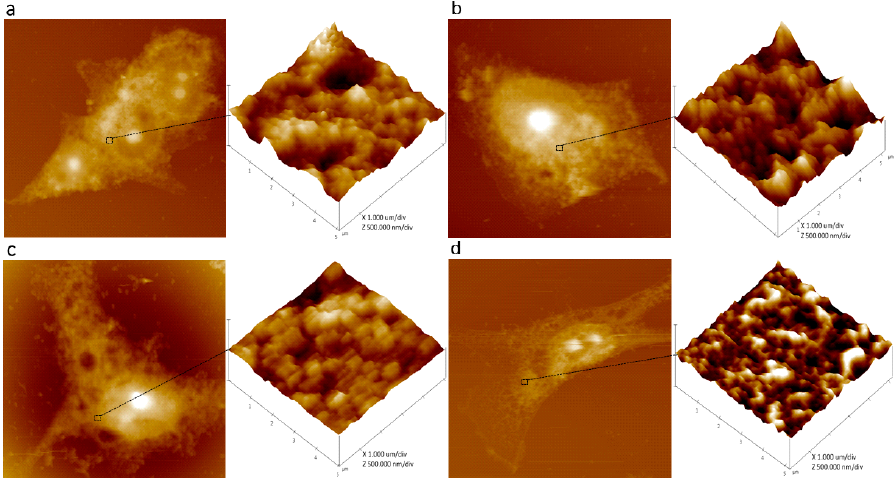
Figure 3. AFM image of ( a ) SKBR3 cells attached on a FSNP (image size: 55.5 µm × 55.5 µm, with z-scale: 0–3.0 µm); ( b ) MCF-7 cell attached on a FSNP (image size: 35.0 µm × 35.0 µm, with z-scale: